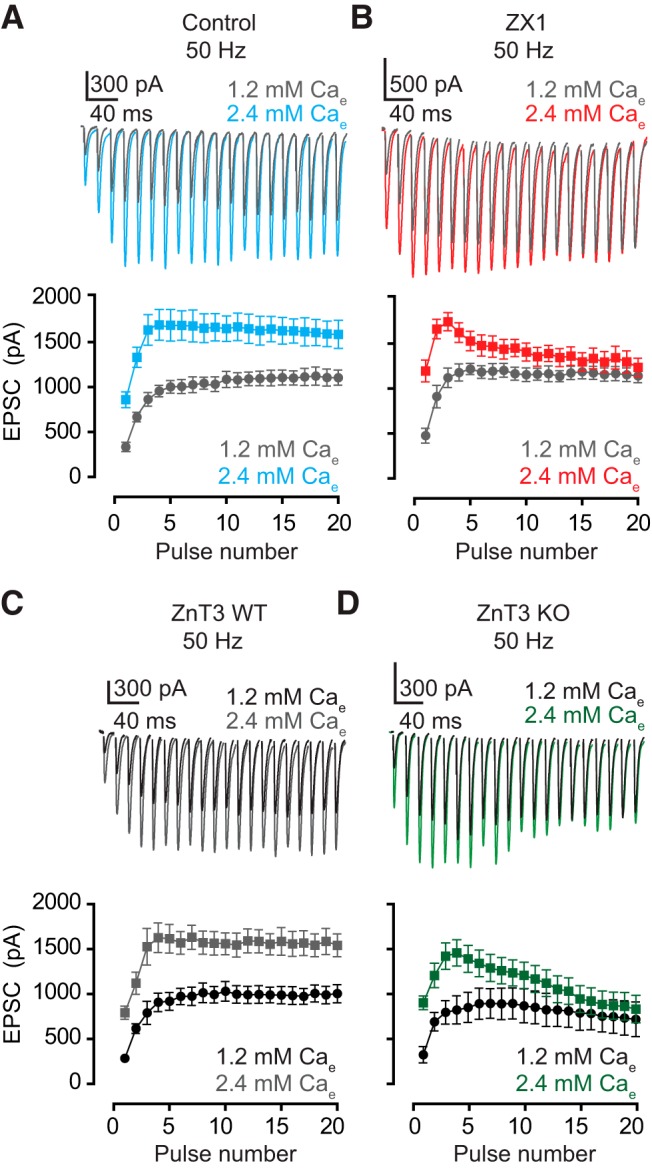
ZnT3-dependent, synaptically released zinc enhances EPSCSS in high Pr. A, B, Upper panels, representative traces of AMPA EPSCs evoked by 50-Hz 20-pulse train in 1.2 mm (gray) and 2.4 mm (color) external calcium in control (A) and ZX1 (B). Lower panels, summary graphs showing average AMPA EPSC amplitudes during the train in 1.2 mm (gray) and 2.4 mm (color) external calcium in control (A) and ZX1 (B; EPSC16–20 amplitude: control: 1.2 vs. 2.4 mm: n = 7, p< 0.01; ZX1: 1.2 vs. 2.4 mm: n = 7, p = 0.09). C, D, Upper panels, representative traces of AMPA EPSCs evoked by 50-Hz 20-pulse train in 1.2 mm (black) and 2.4 mm (gray or green) external calcium in ZnT3WT (C) and ZnT3KO mice (D). Lower panels, summary graphs showing average AMPA EPSC amplitudes during the train in 1.2 mm (black) and 2.4 mm (gray or green) external calcium in ZnT3WT (C) and ZnT3KO mice (D; ZnT3 WT: 1.2 vs. 2.4 mm: n = 5, p < 0.01; ZnT3KO: 1.2 vs. 2.4 mm: n = 5, p = 0.24). Values represent mean ± SEM. Detailed values and statistical tests. A, B, lower panels: EPSC16–20 amplitude: control: 1.2 mm calcium: 1109 pA ± 90 pA vs. 2.4 mm calcium: 1605 pA ± 147 pA, n = 7, p < 0.01, F = 40.89, DFn = 1, DFd = 60; ZX1: 1.2 mm calcium: 1158 pA ± 75 pA vs. 2.4 mm calcium: 1301 pA ± 116 pA, n = 7, p = 0.09, F = 2.9, DFn = 1, DFd = 60; two-way ANOVA. C, D, lower panels: EPSC16–20 amplitude. ZnT3WT: 1.2 mm calcium: 996 pA ± 95 pA vs. 2.4 mm calcium: 1564 pA ± 135 pA, n = 5, p < 0.01, F = 58.51, DFn = 1, DFd = 40; ZnT3KO: 1.2 mm calcium: 750 pA ± 185 pA vs. 2.4 mm calcium: 876 pA ± 156 pA, n = 5, p = 0.24, F = 1.40, DFn = 1, DFd = 40; two-way ANOVA.